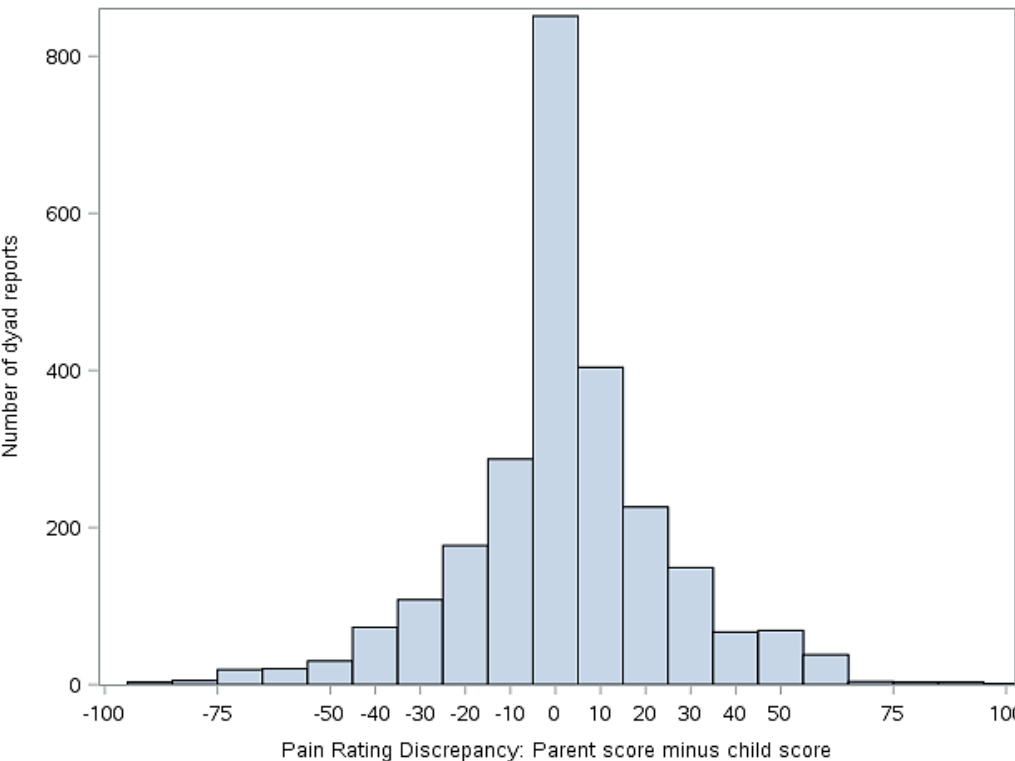
Figure 3. Discrepancy between child and parent ratings of child pain (parent score minus child score). Positive values indicate that the parent scored pain higher than the child. Negative numbers indicate that the child scored pain higher than the parent.